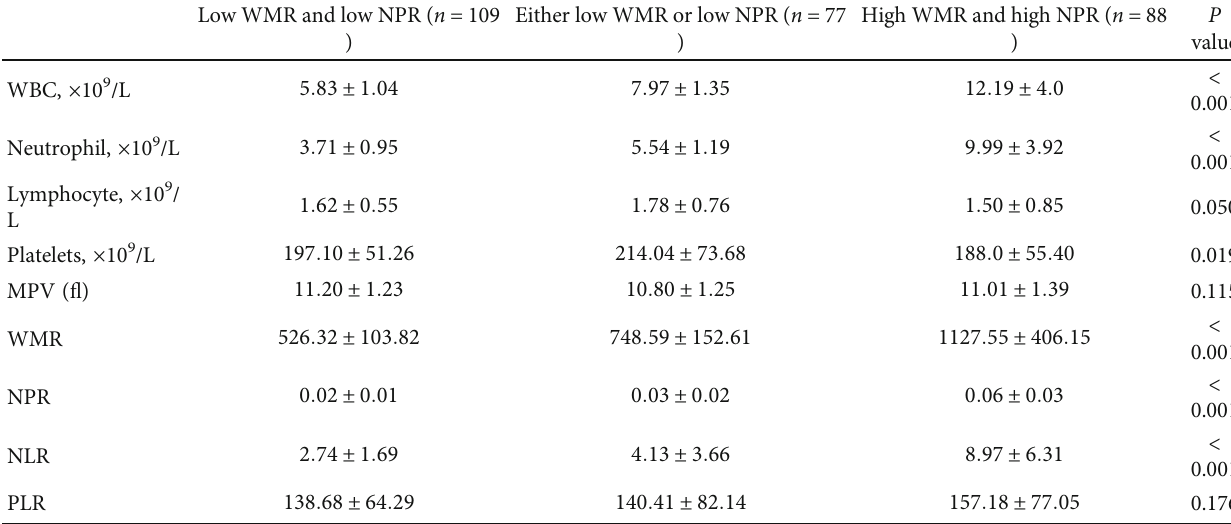
Table 2: Biochemical data based on the WMR and NPR.